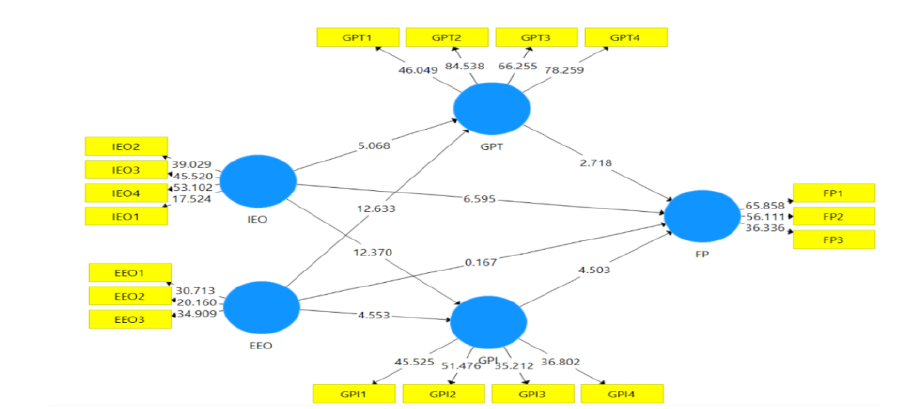
Figure 2: Evaluation of the measurement